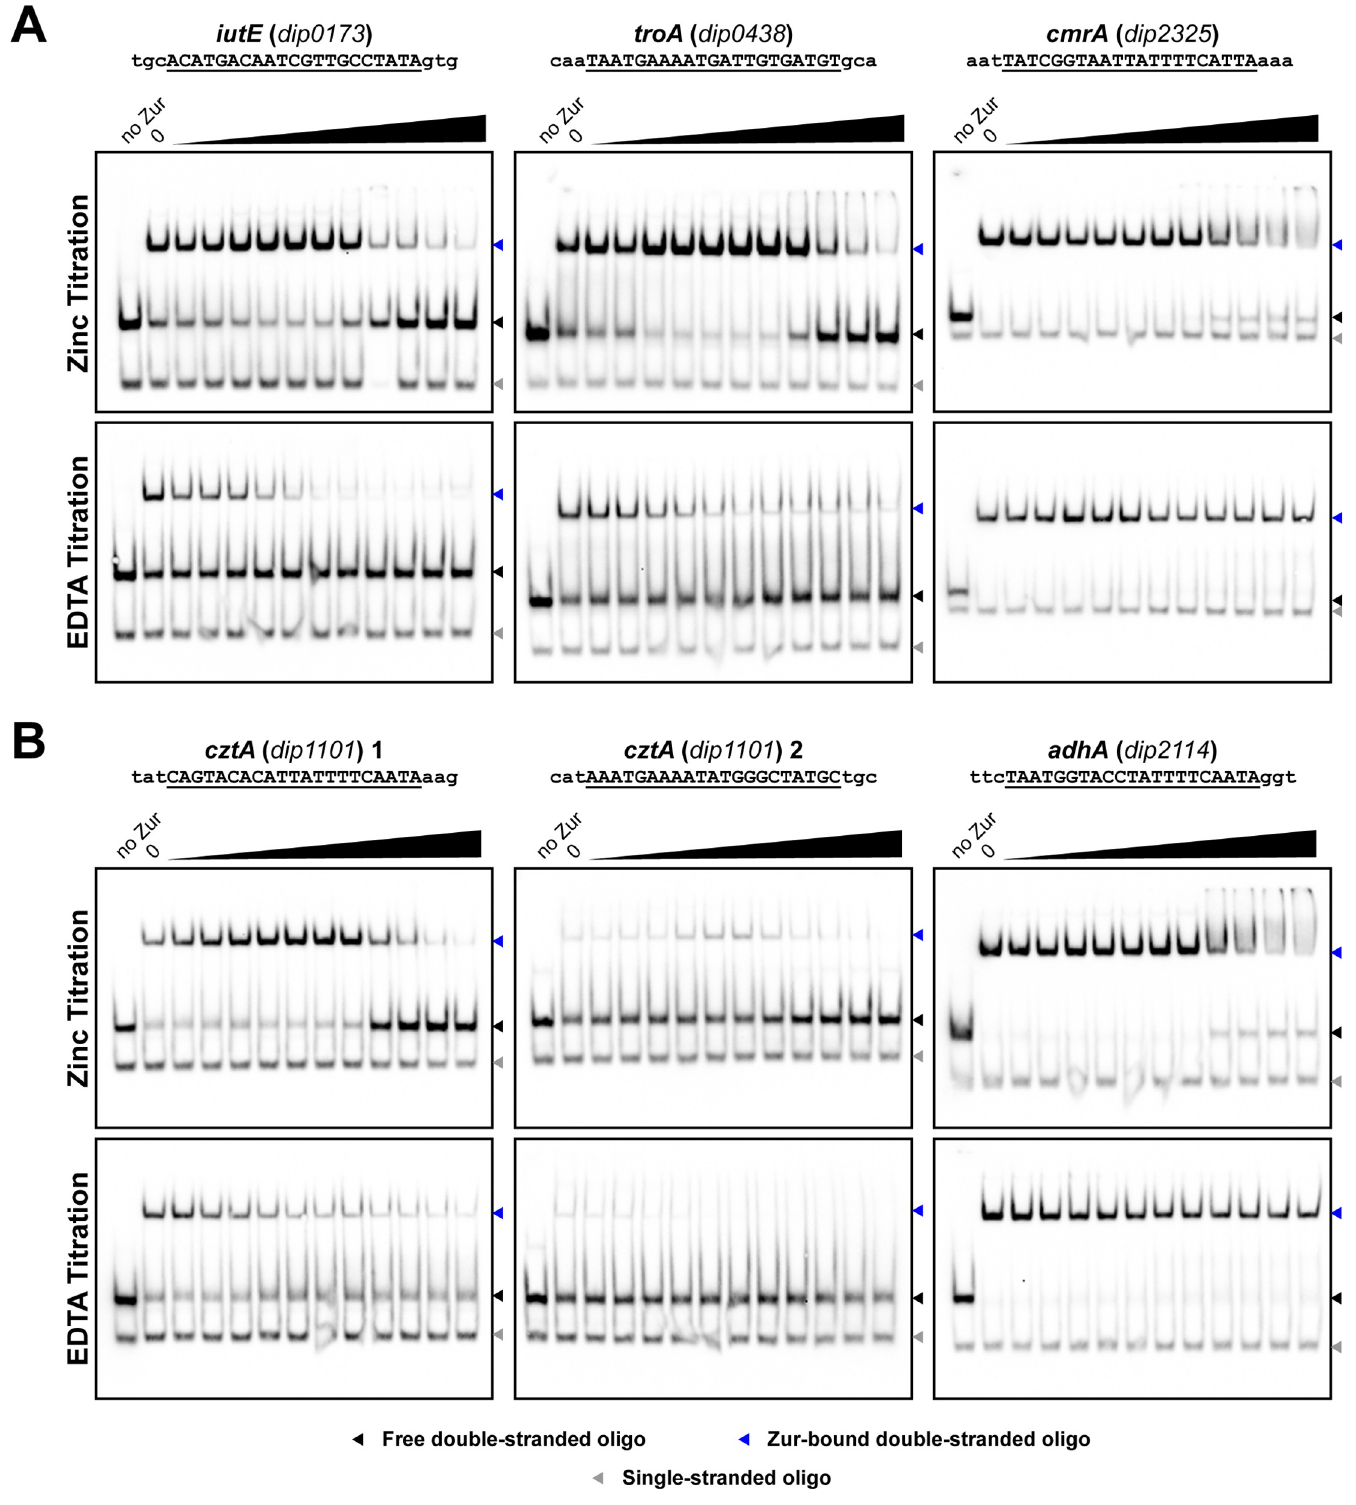
Fig 6. Testing metal dependence on Zur binding. Binding sites for genes which are zinc-repressed (A) and zinc-activated (B) were tested for binding in the presence of increasing concentrations of zinc or EDTA from approximately 0.25 μ M to 250 μ M in 2-fold increments. Binding sequences are shown with the Zur binding sequence underlined. Recombinant Zur was present at a concentration of 100 nM in all reaction conditions, except where indicated.